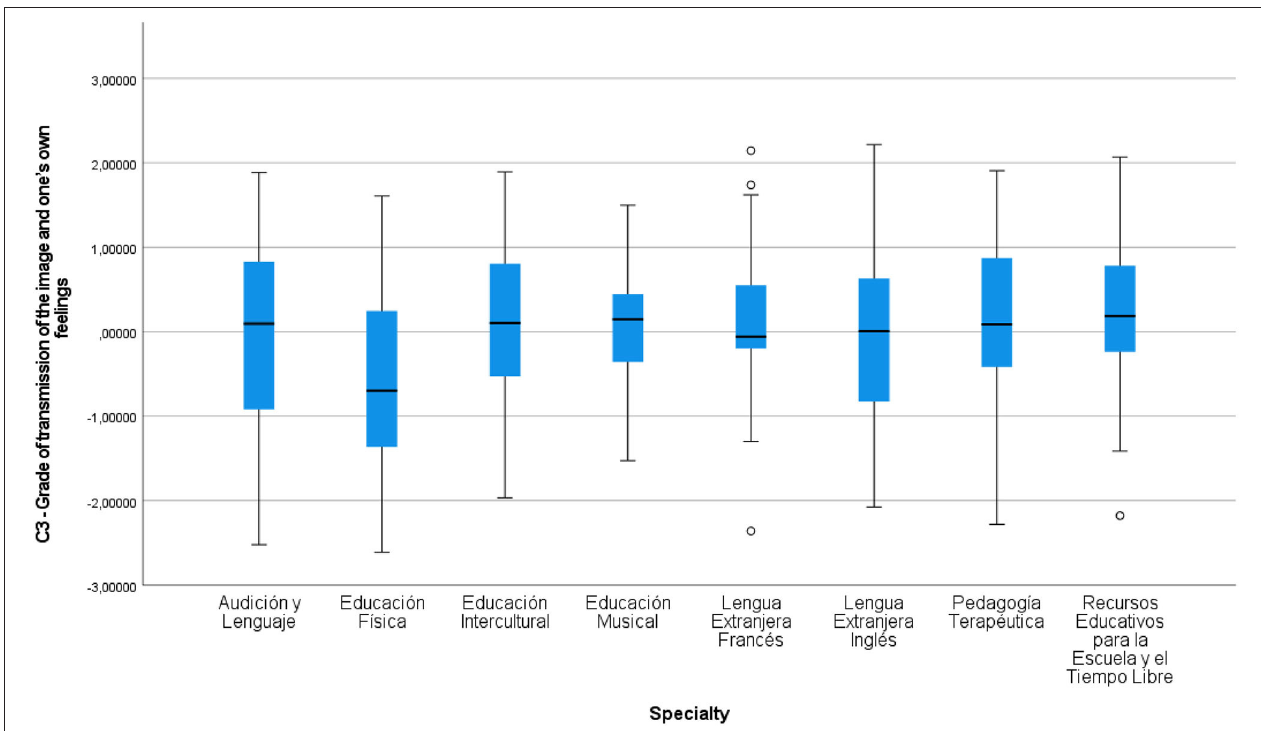
FIGURE 5 | Kruskall-Wallis H for independent samples. Comparative